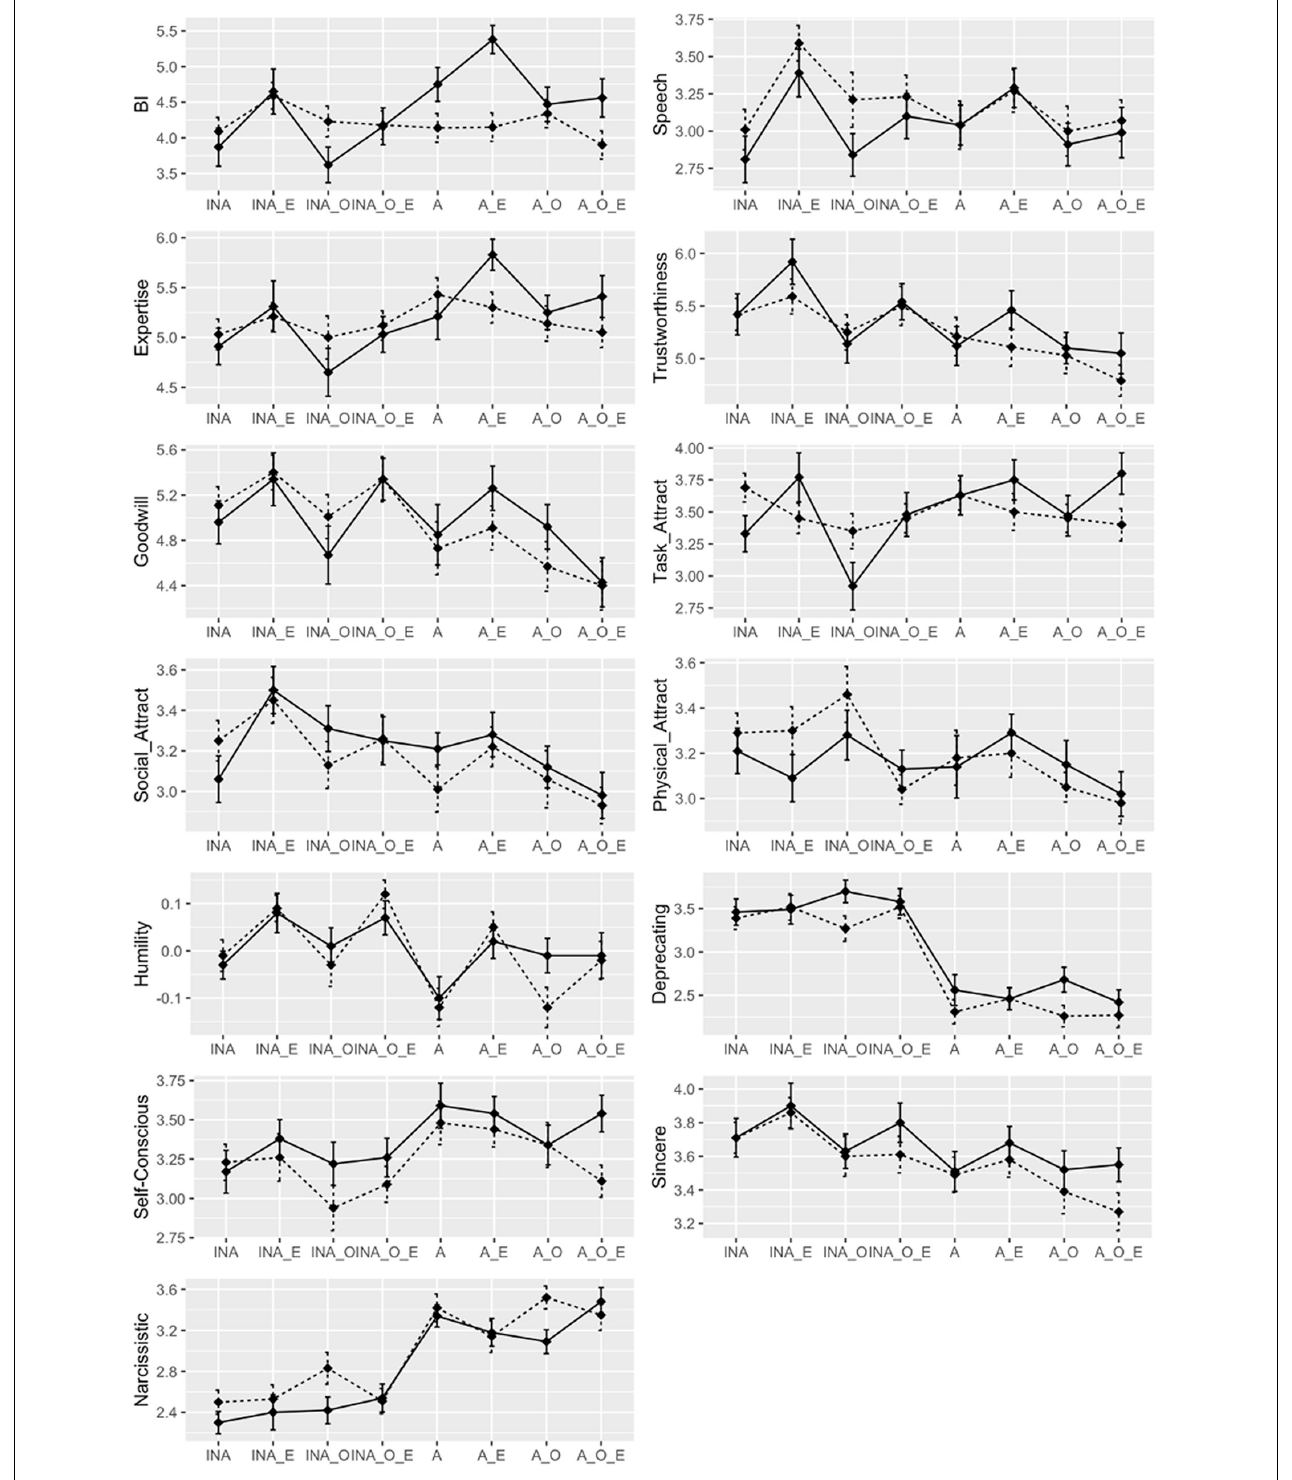
FIGURE 2 | Message by source interaction on the major outcome variables. —- Poet — Doctor. BI = Behavioral intention to interact with the source; INA = Inaccurate self-perception or self-deprecation; INA_E = Self-deprecation + Egalitarianism; INA_O = Self-deprecation + Open-mindedness; INA_O_E = Self-deprecation + Open-mindedness + Egalitarianism; A = Accurate self-perception; A_E = Accurate self-perception + Egalitarianism; A_O = Accurate self-perception + Open-mindedness; A_O_E = Accurate self-perception + Open-mindedness + Egalitarianism. Error bars indicate CI 68% .